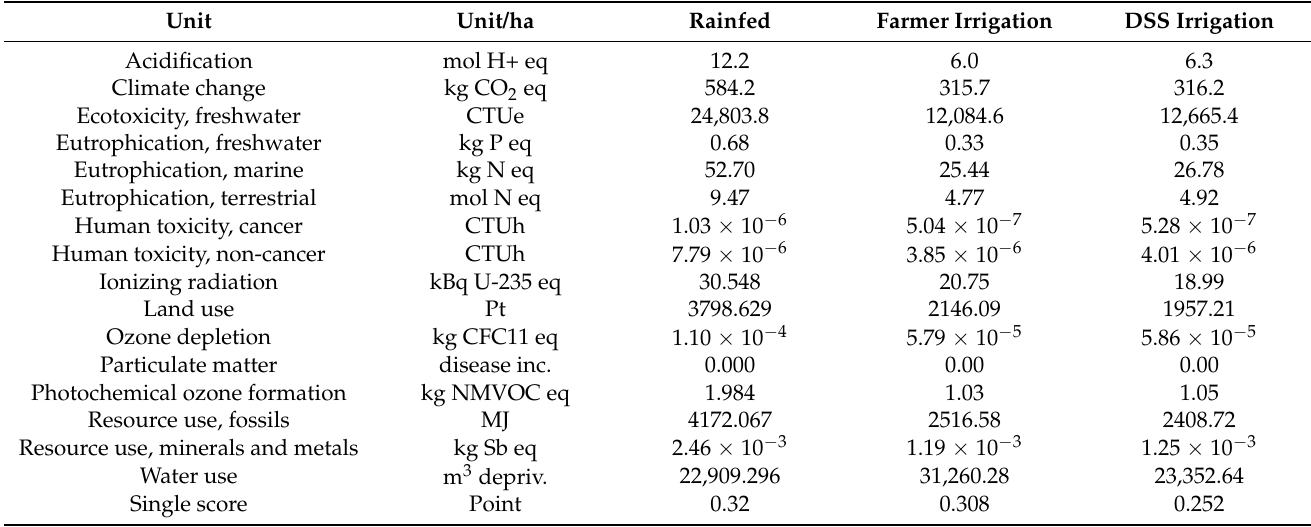
Table A6. LCA results with the EF